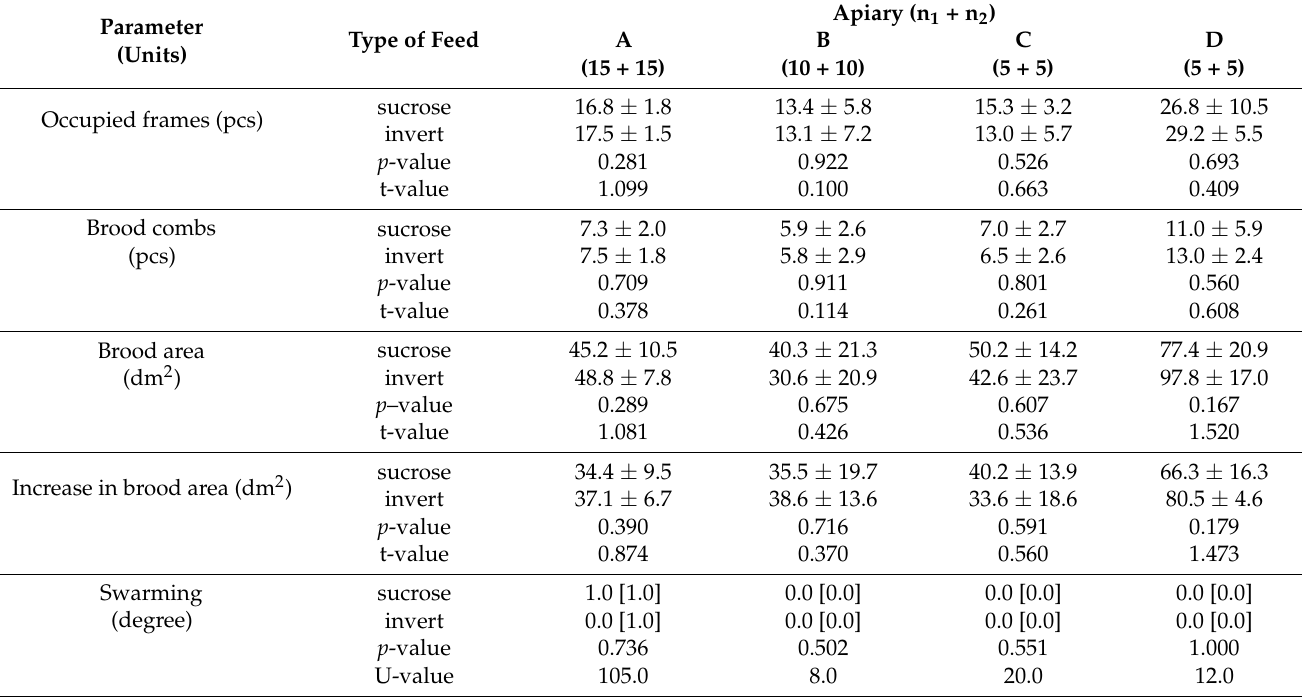
Table 5. Colony growth in the late spring during blooming of cherry-trees and sorted according to apiary A–D and type of feed. Differences among groups were tested as in Tables 3 and 4 and were not statistically significant at any apiary.